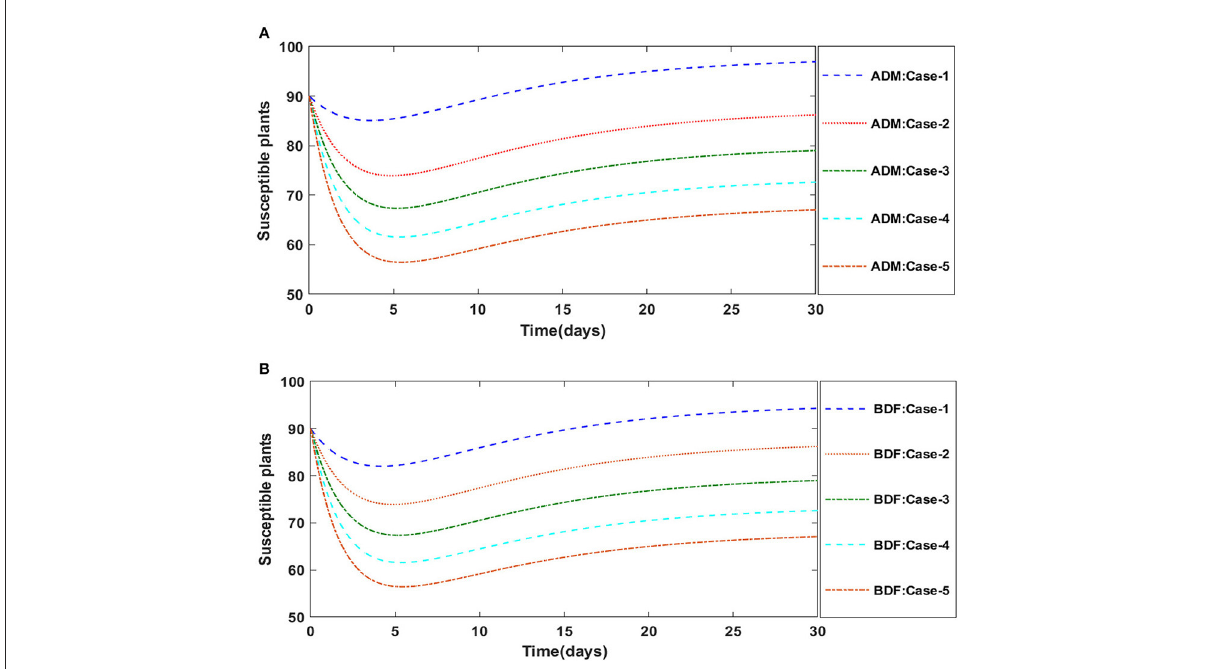
FIGURE10 (A) Dynamics of susceptible plants for the varition in γ using ADM for model A2. (B) Dynamics of susceptible plants for the varition in γ using BDF for model A2.